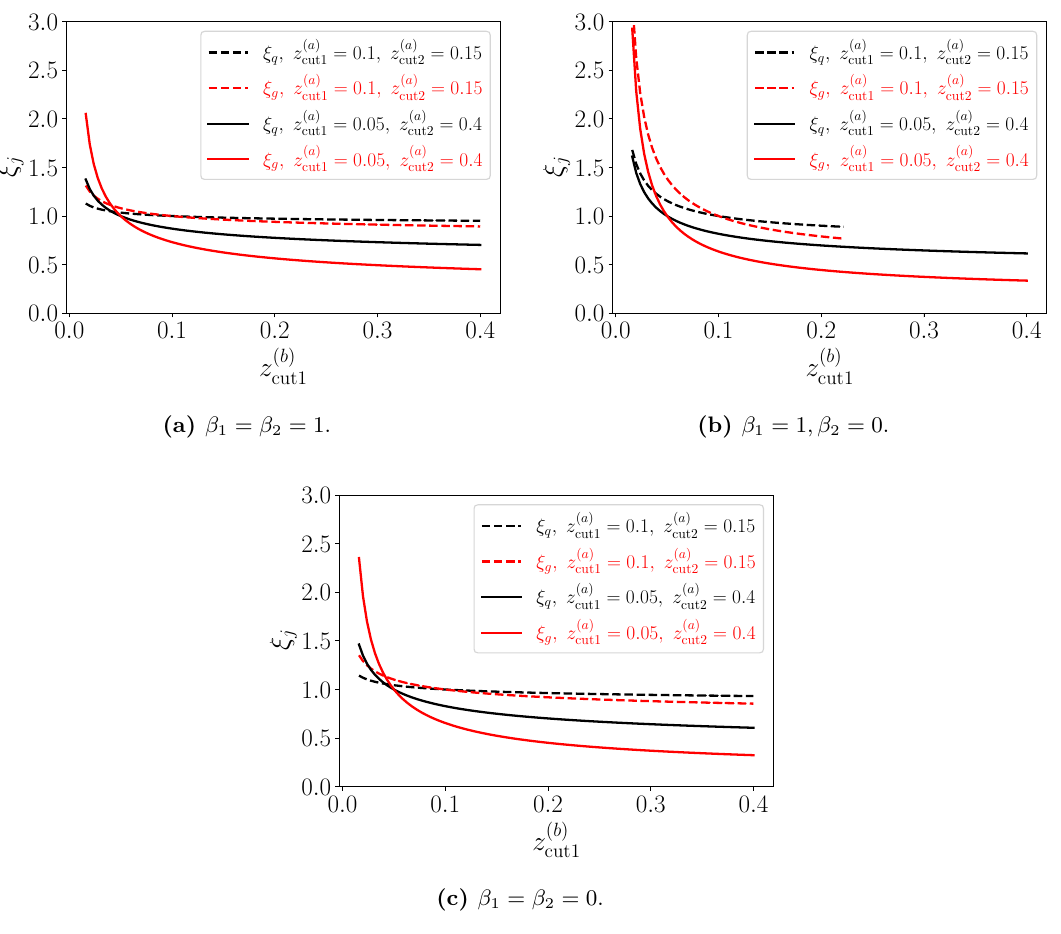
Figure 3. Values of ξ j as functions of z ( b ) η J = 0 and R = 0 . 2 . The three different panels show three choices for β 1 and β 2 . For the case with β 1 = 1 , β 2 = 0 , z cut1 = 0 . 1 and z cut2 = 0 . 15 , the curves are truncated when the condition z ( b ) ≥ z ( b ) is cut2 cut1